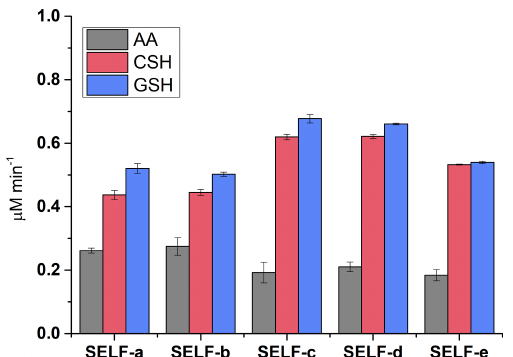
Figure 6. The effects of SELF composition on antioxidant deple- tion rates in the presence of 20µgmL − 1 SRM following 180min incubation. The details of SELF formulations are given in Table